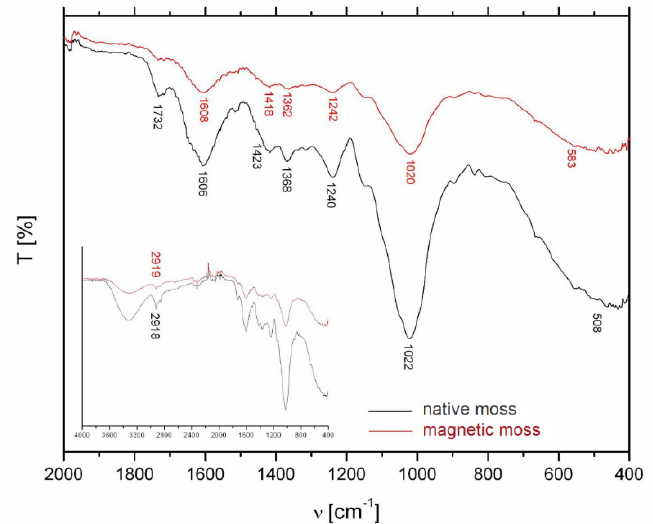
Figure 4. FTIR spectra of R. squarrosus biomass before and after magnetic modification. Inset: the whole FTIR spectrum in mid-infrared region.